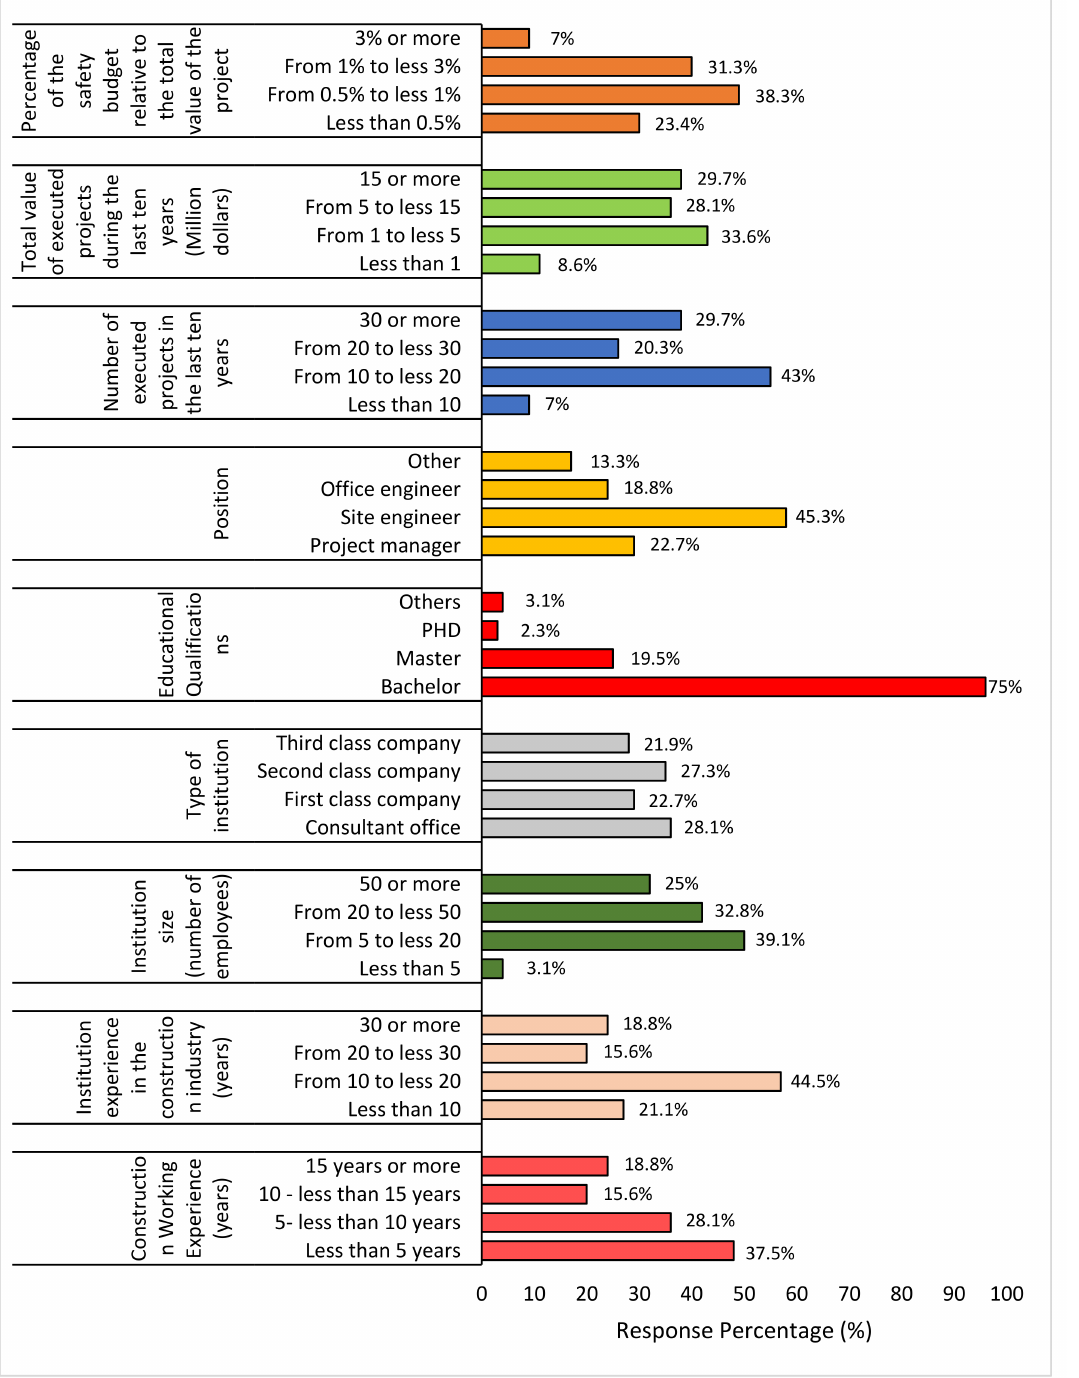
Figure 4. Distribution of study